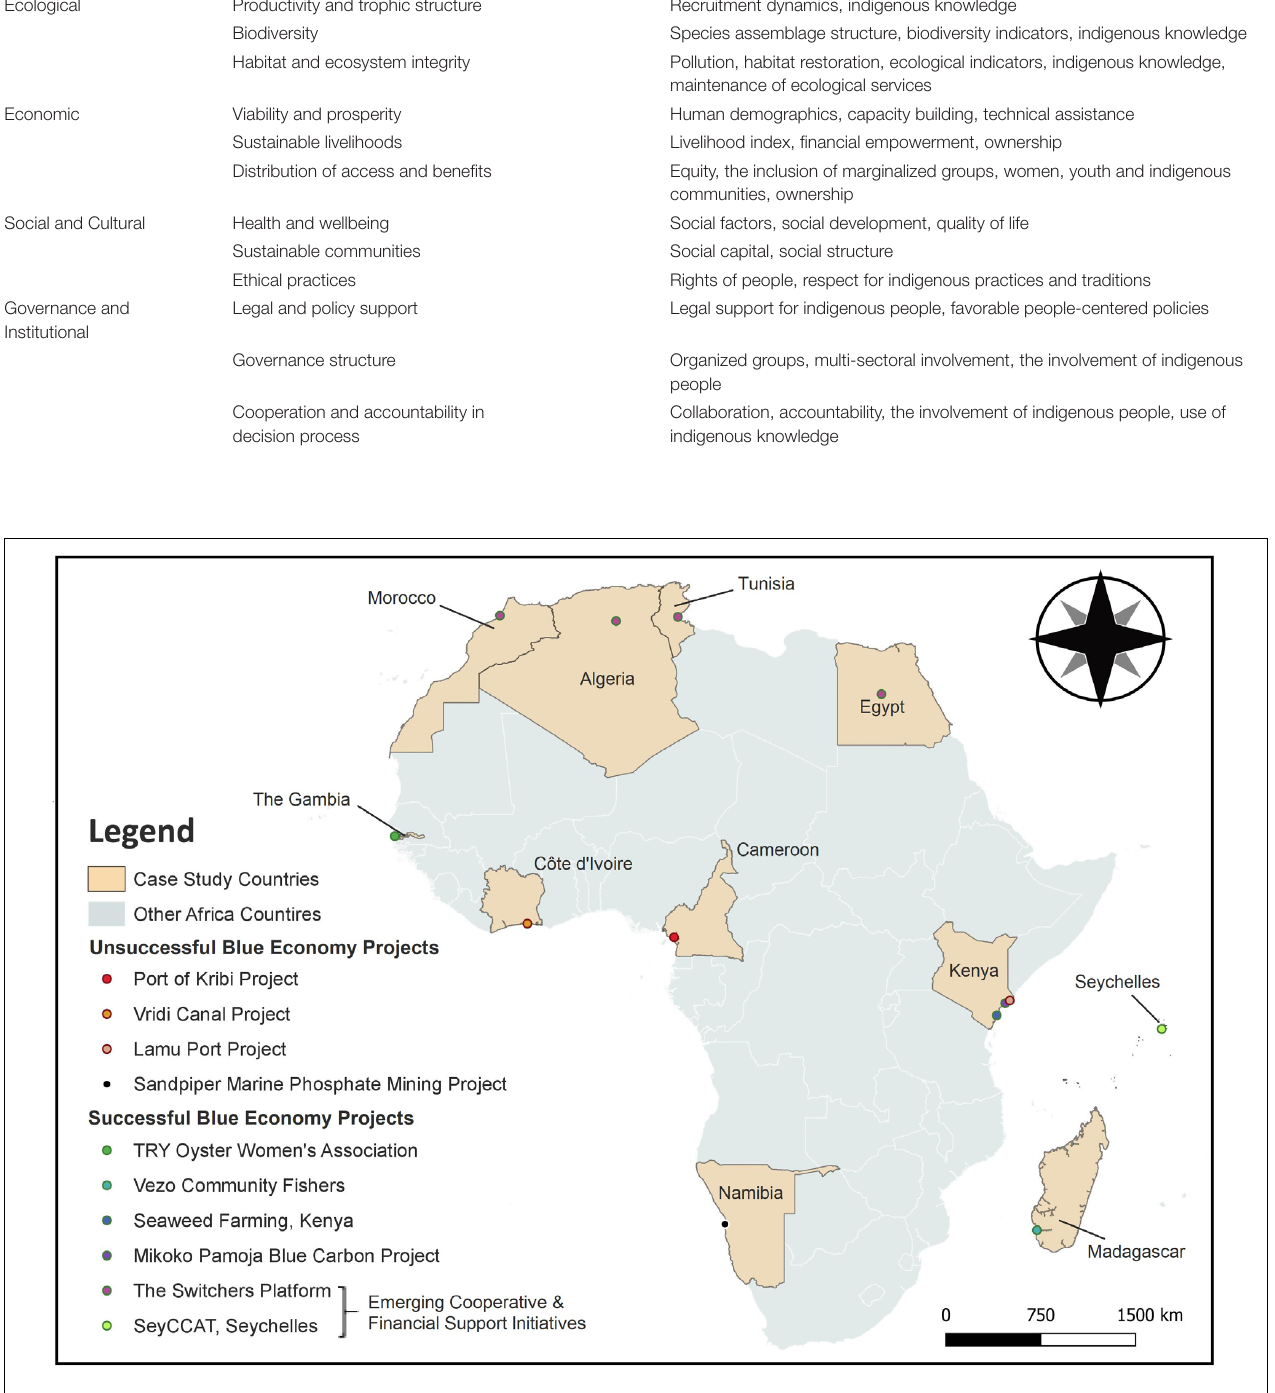
Frontiers in Marine Science |